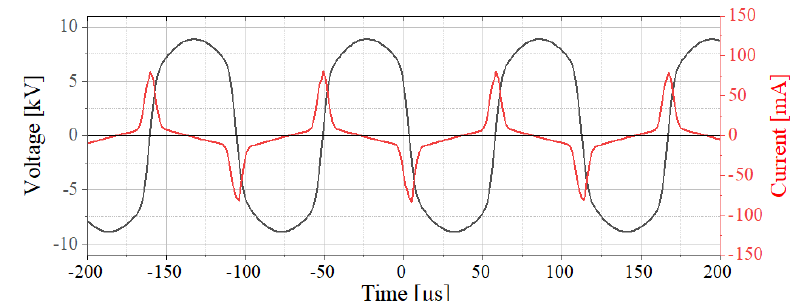
Figure 3. U–I–characteristics of the plasma source at a power of approx.